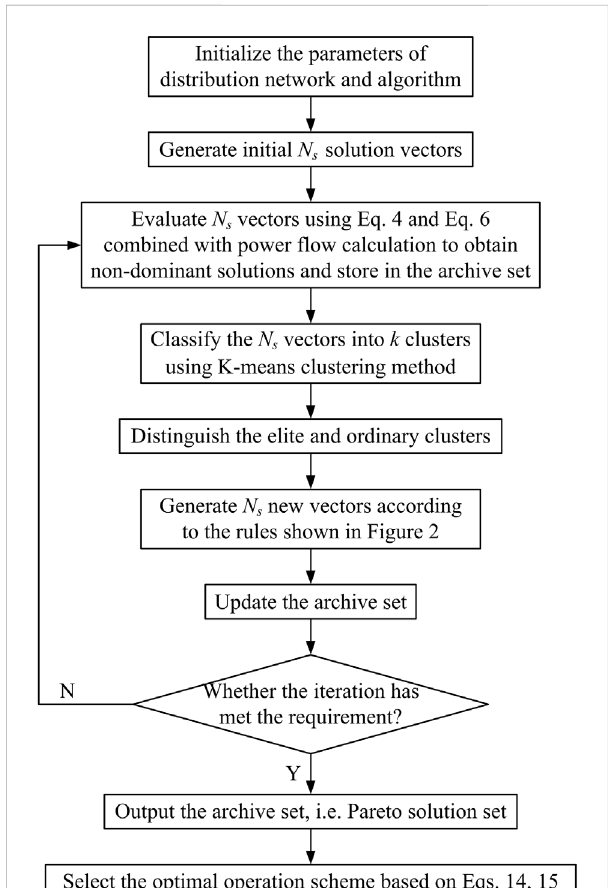
FIGURE 3 Flowchart of solution method for optimal operation model.